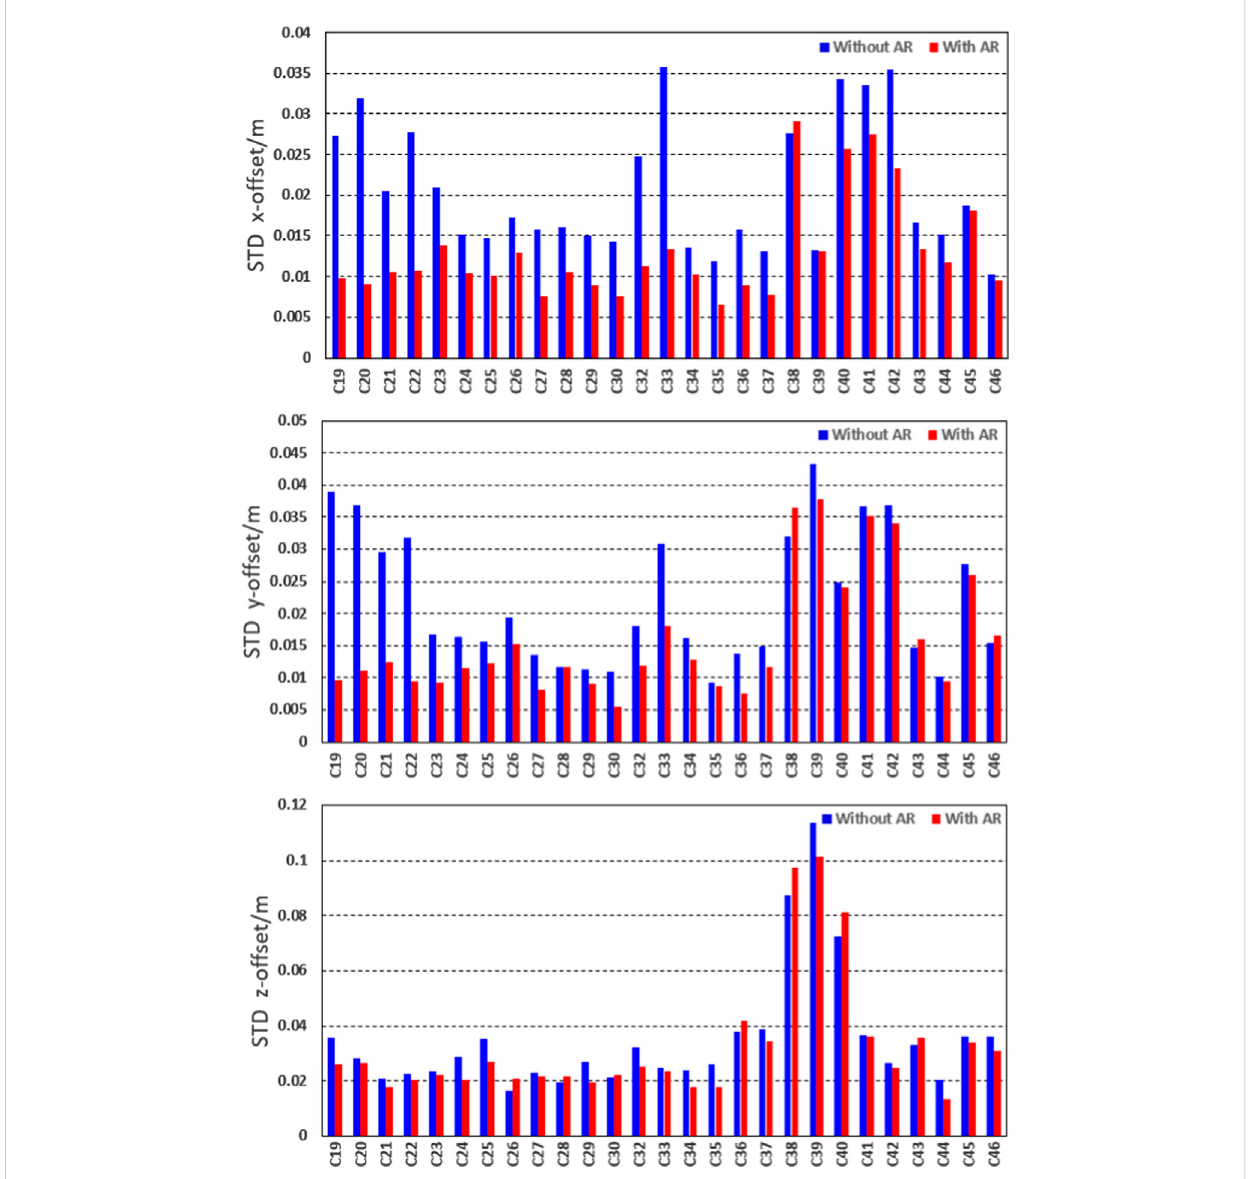
FIGURE 5 Statistical STD values of calibrated PCOs in the x-component (the upper panel), y-component (the middle panel), and z-component (the bottom panel) for all BDS-3 satellites without ambiguity resolution (the blue bars) and with ambiguity resolution (the red bars) during 14 days.